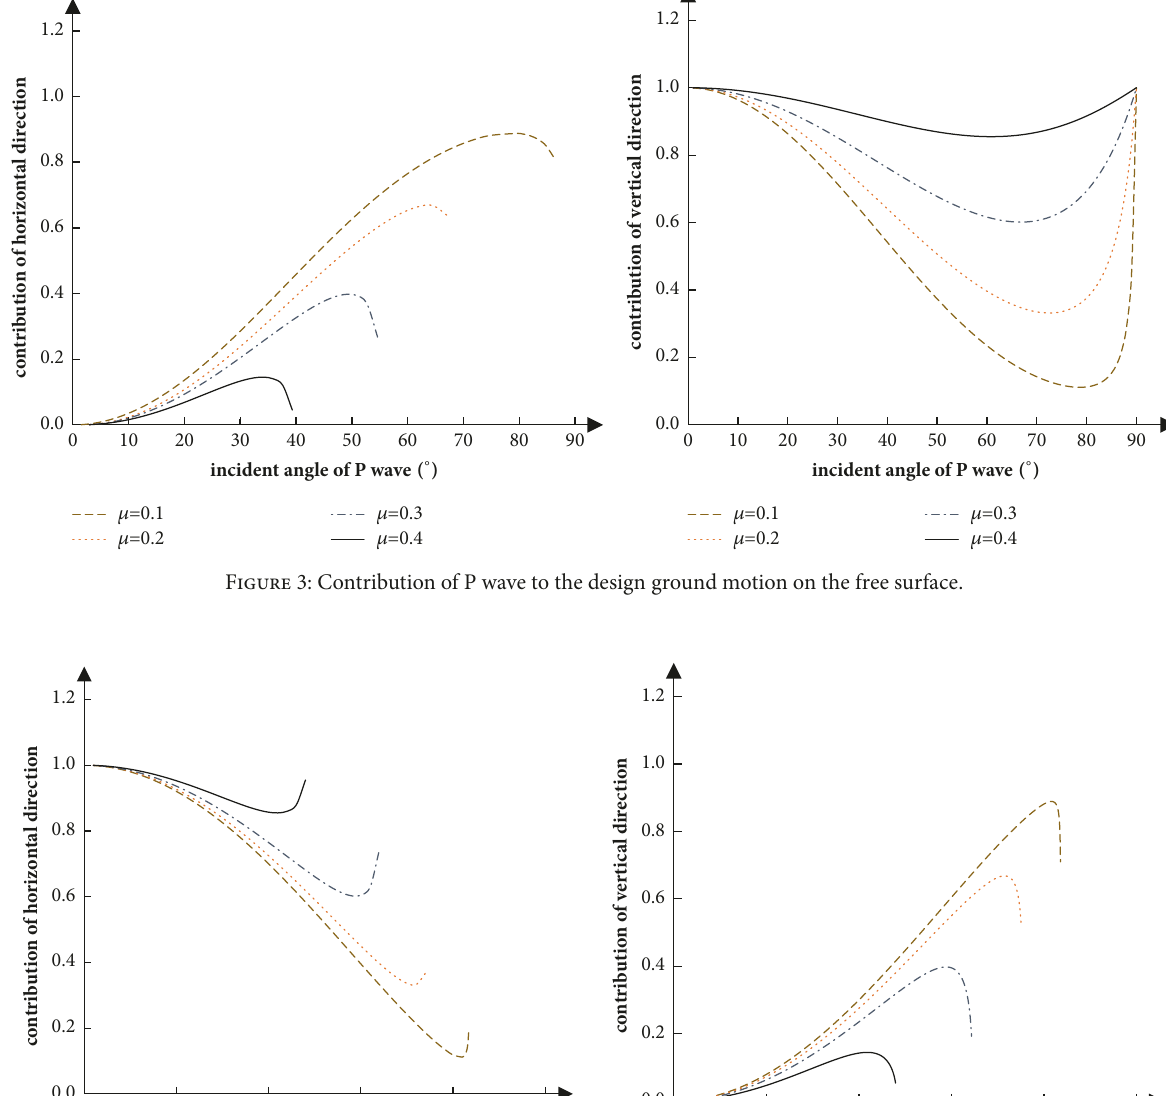
generally applied to the small incident angle of a plane